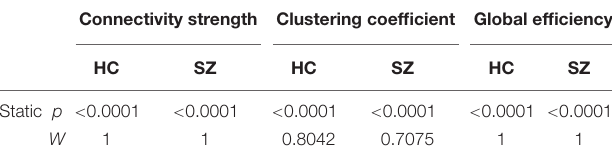
TABLE 1 | Effect of cost on static network measures.